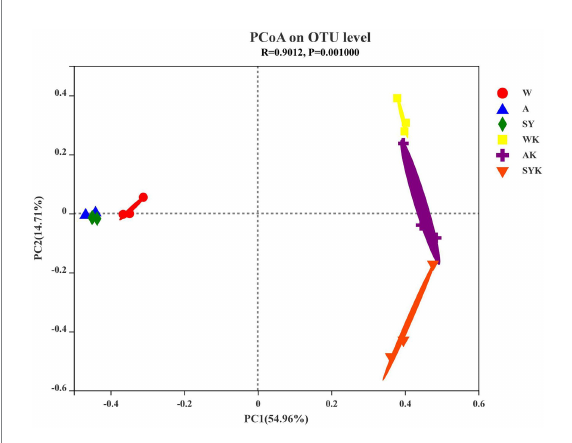
FIGURE 3 The principal coordinate analysis (PCoA) plot showing variation in bacterial community structure of three regions. W, Raw materials of Ordos-wushenqi; A, Raw materials of Hohhot; SY, Raw materials of Ulanqab-siziwangqi; WK, Ryegrass silages of Ordos- wushenqi; AK, Ryegrass silages of Hohhot; SYK, Ryegrass silages of